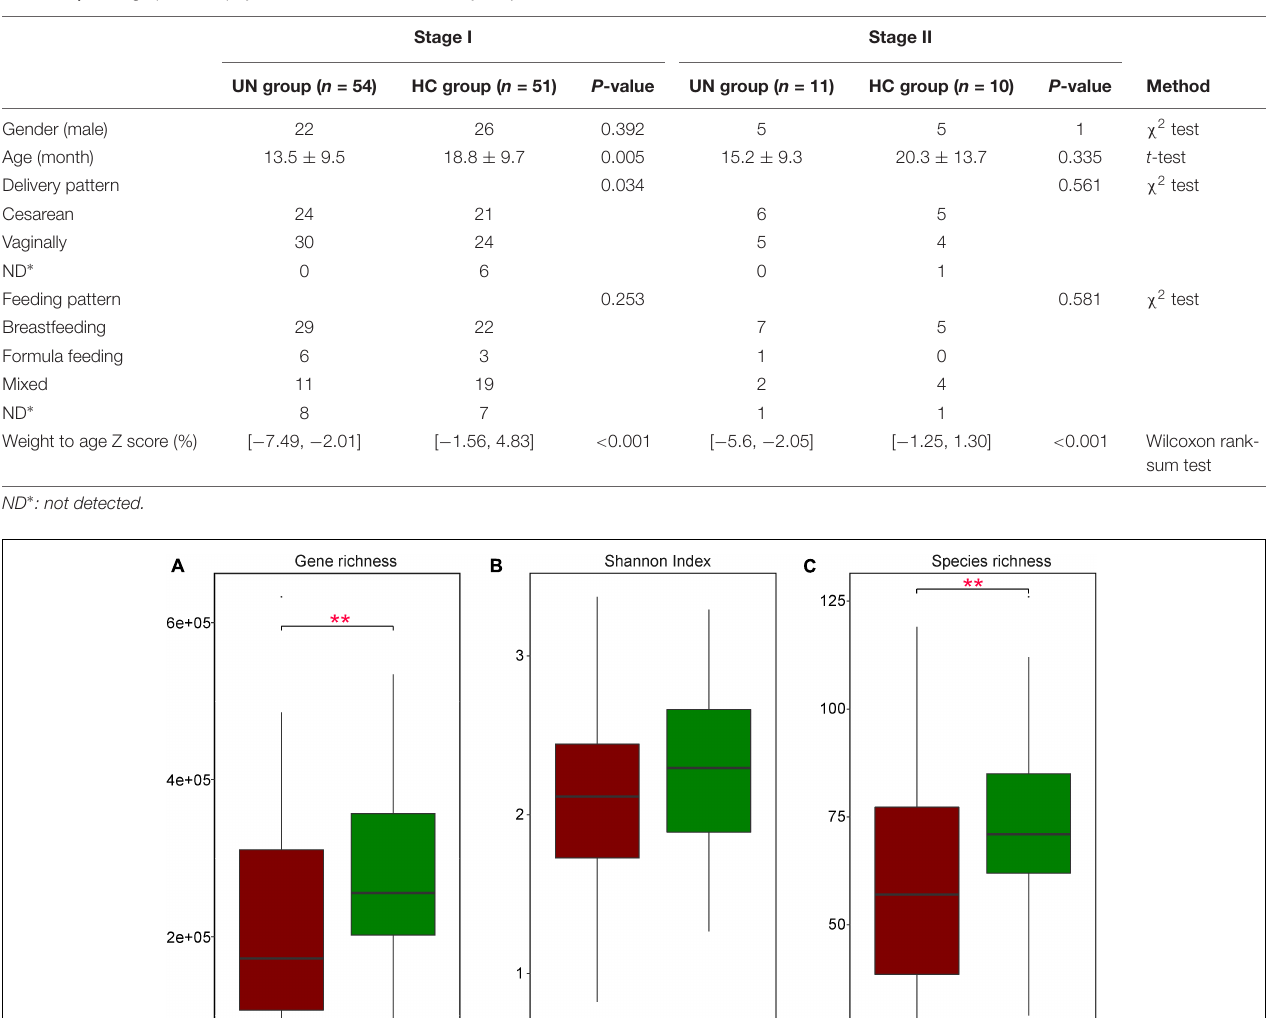
TABLE 1 | Demographic and physical features of the 126 study subjects.